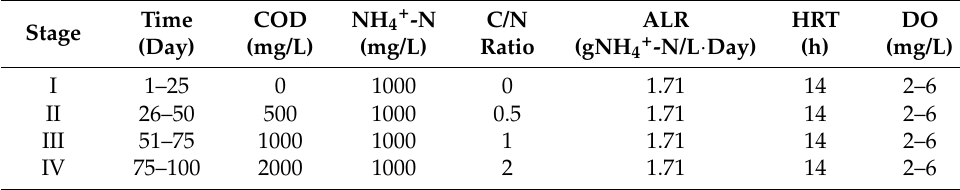
Table 1. Operation conditions of the MBR